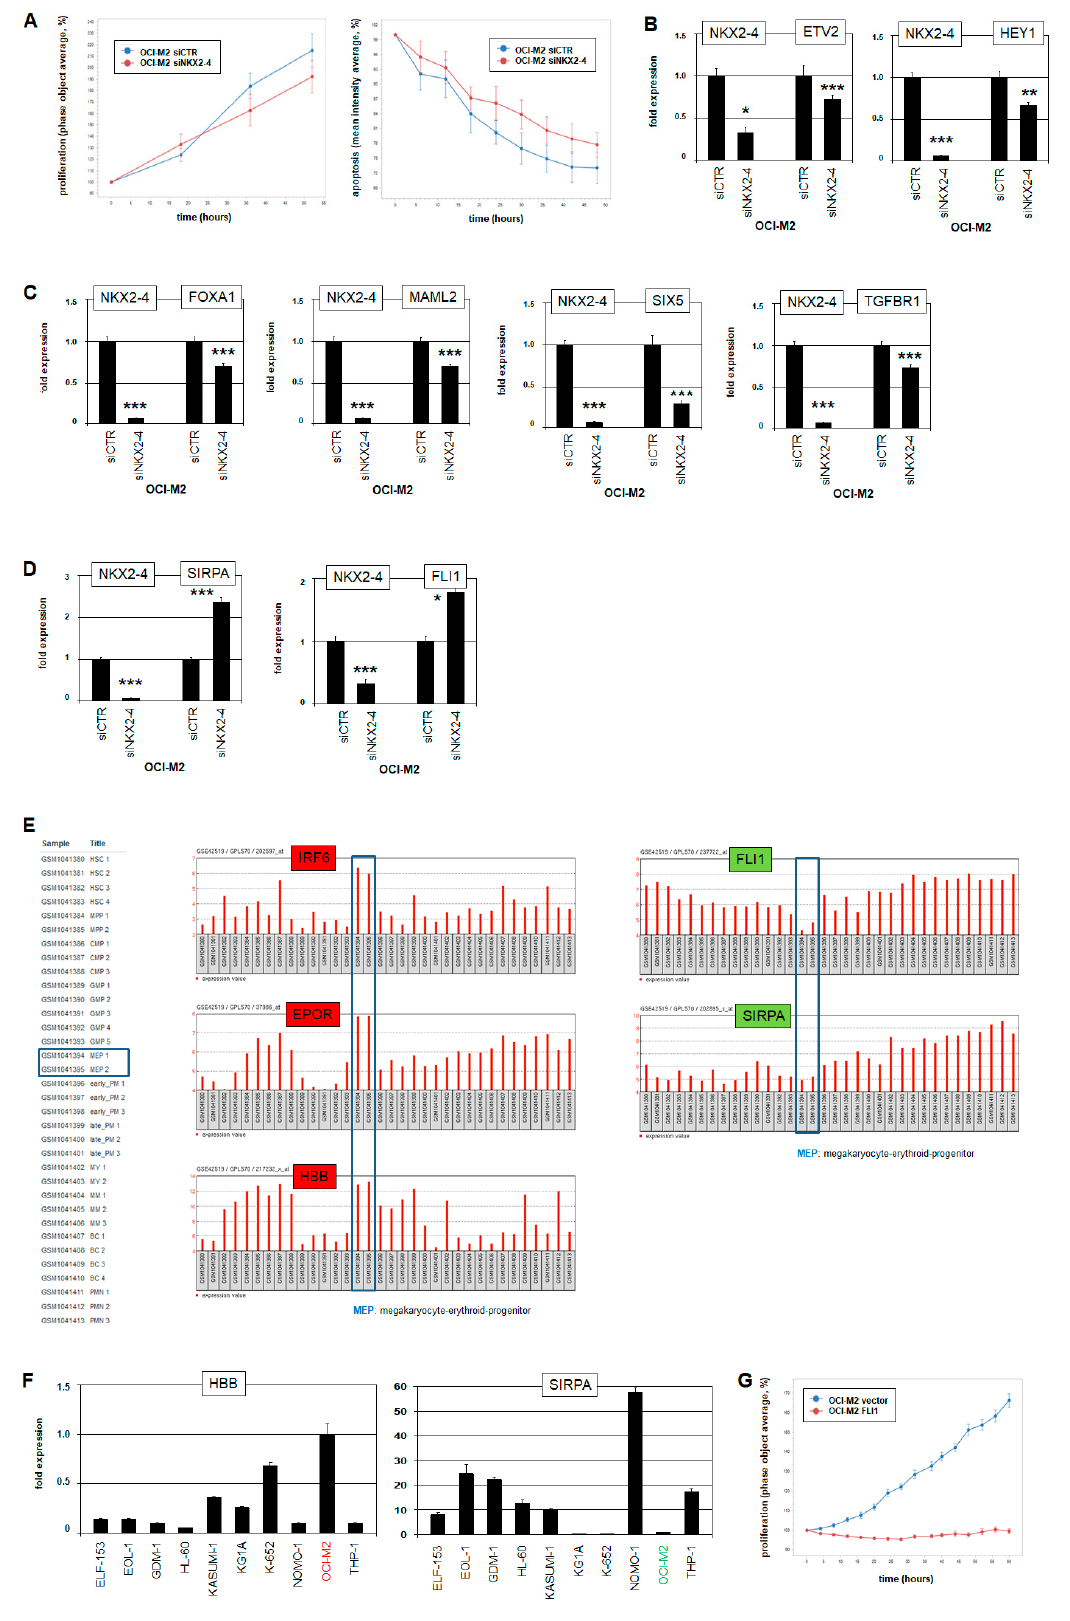
Figure 5. NKX2-4 target gene analyses. ( A ) Life-cell imaging analysis of OCI-M2 cells treated by siRNA-mediated knockdown of NKX2-4 show no significant impact in proliferation ( left ) or apoptosis ( right ). ( B ) RQ-PCR analyses